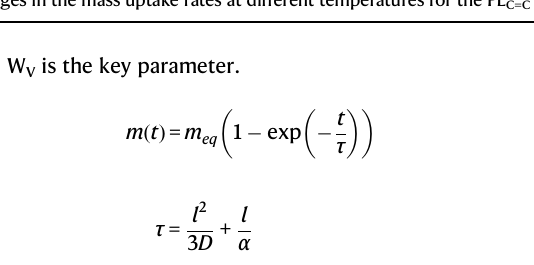
Fig. 5 | Methanol uptake at variable temperature and concentration gradient. a % changes in the mass uptake rates at different temperatures for the PL C=C and